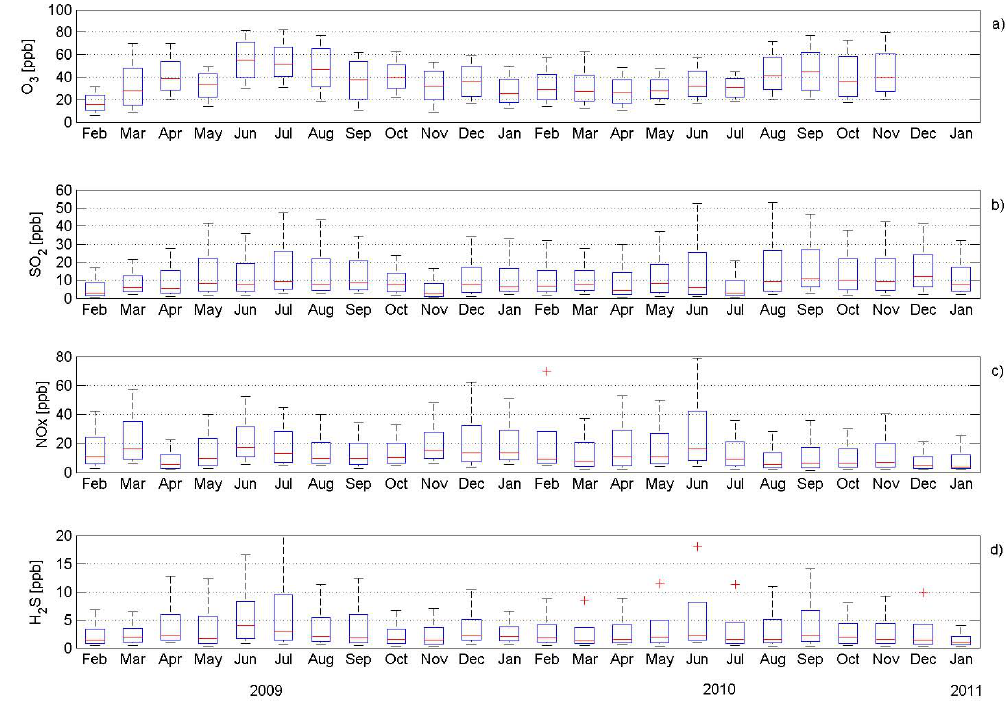
Fig. 6. Concentrations of gas phase species at Elandsfontein: monthly averages of (a) O 3 , (b) SO 2 , (c) NO x , and (d) H 2 S on the basis of hourly data for the period 11 February 2009–31 January 2011. The red lines represent the 50% percentile, the blue boxes the 25 and 75% percentiles and the black whiskers the 5 and 95%